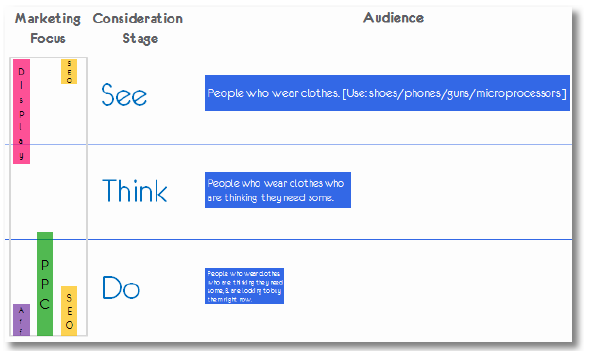
Figure 4. See-Think-Do approach, according to Kaushik